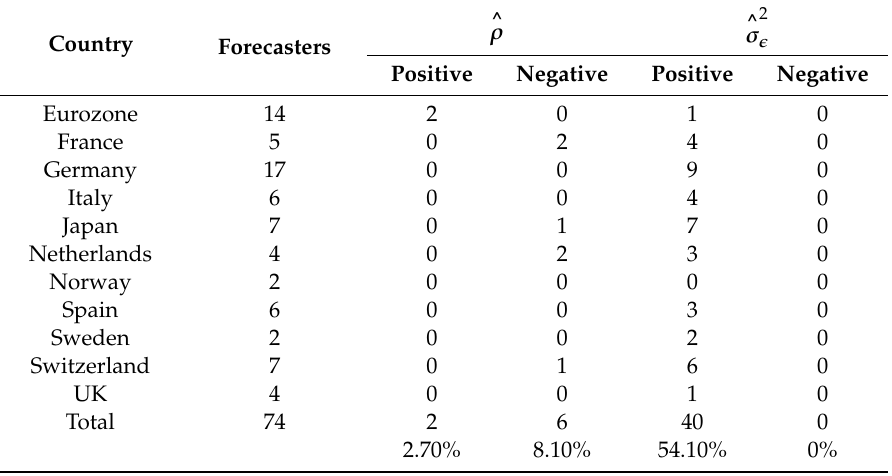
Table 5. Results for regression model (1) for other countries or regions, inflation. The counts concern the number of cases with 10% significant estimation